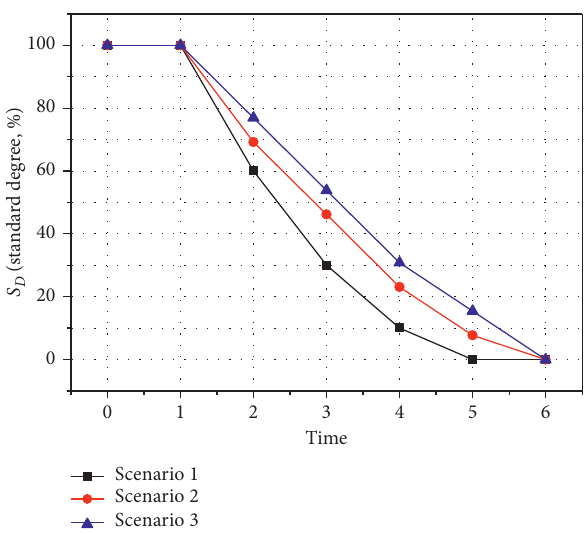
Figure 3: Response of standard degree in three network perco- lation